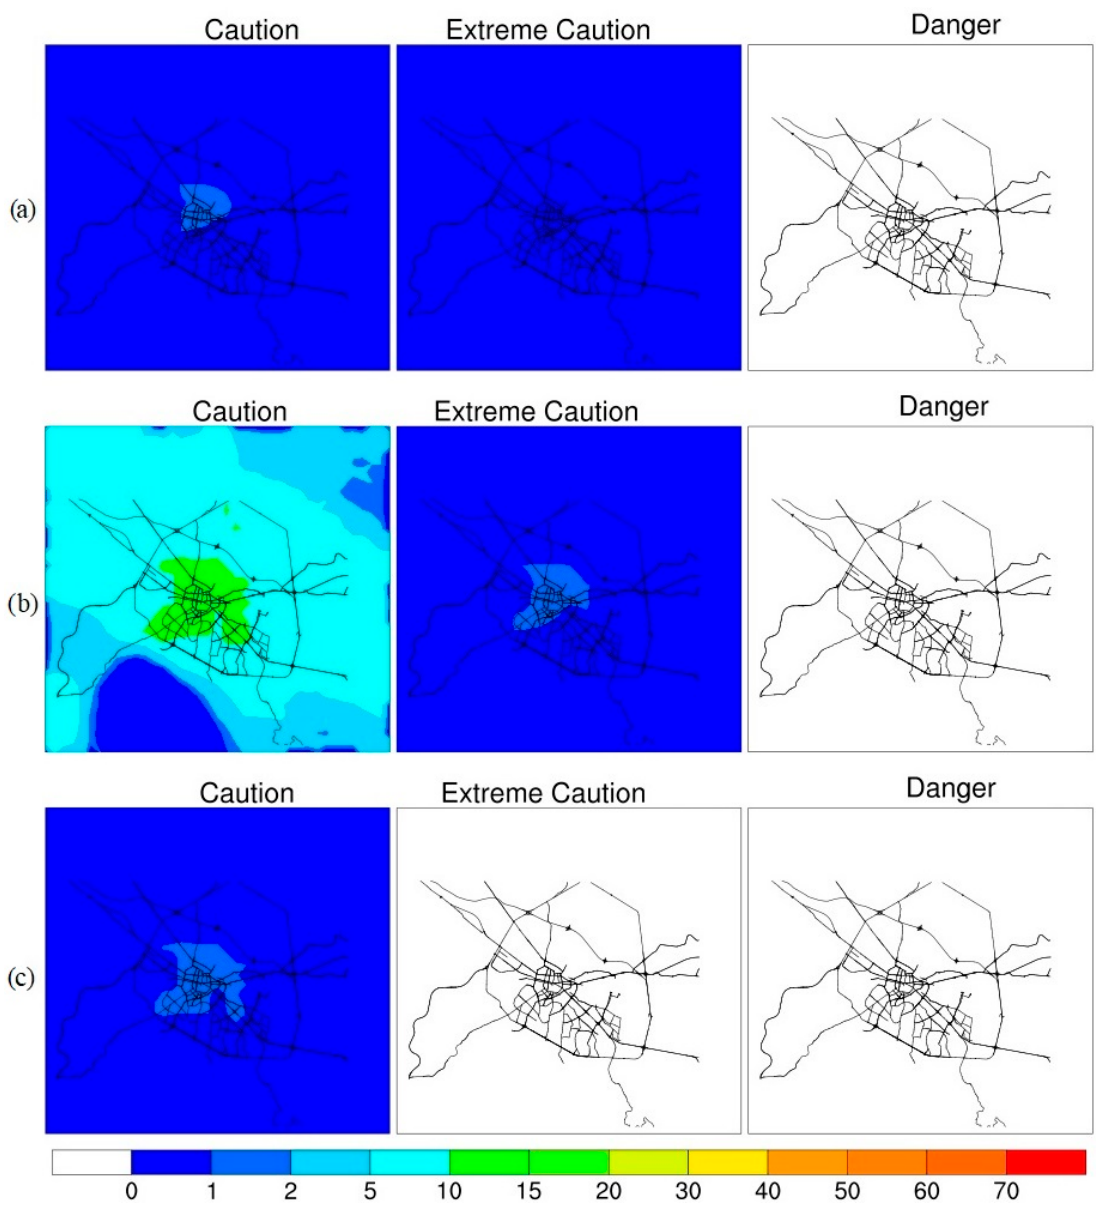
Figure 6. Frequency (in %) for ( a ) spring, ( b ) summer, and ( c ) autumn of the Heat index categories in the Sofia region during the spring (first row), summer (second row), and autumn (third row).